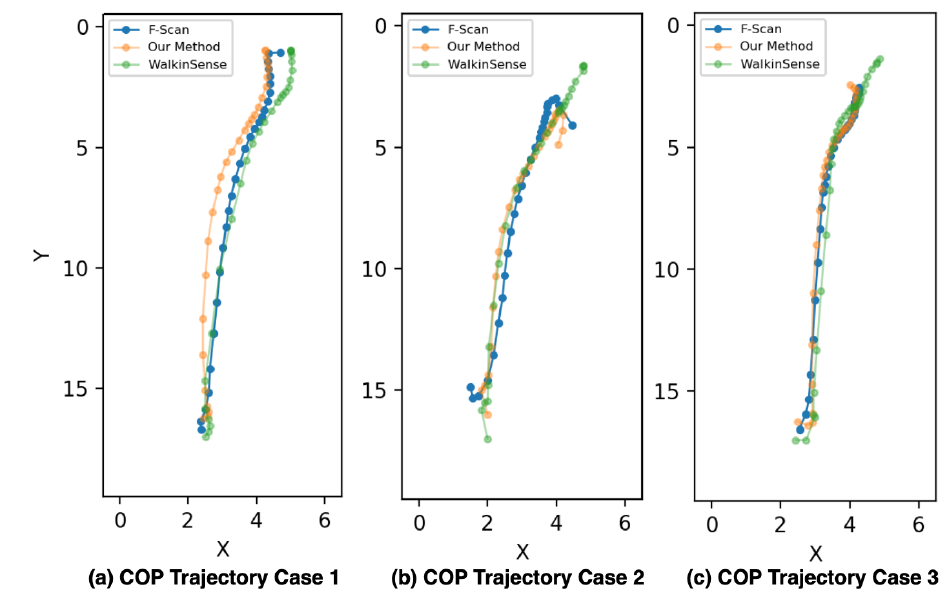
Figure 9. Illustrate the COP Trajectory difference between our method and